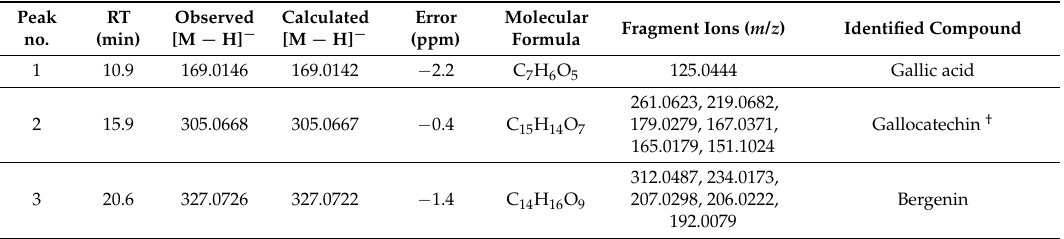
Identification of compounds from ethyl acetate fraction of L. indica